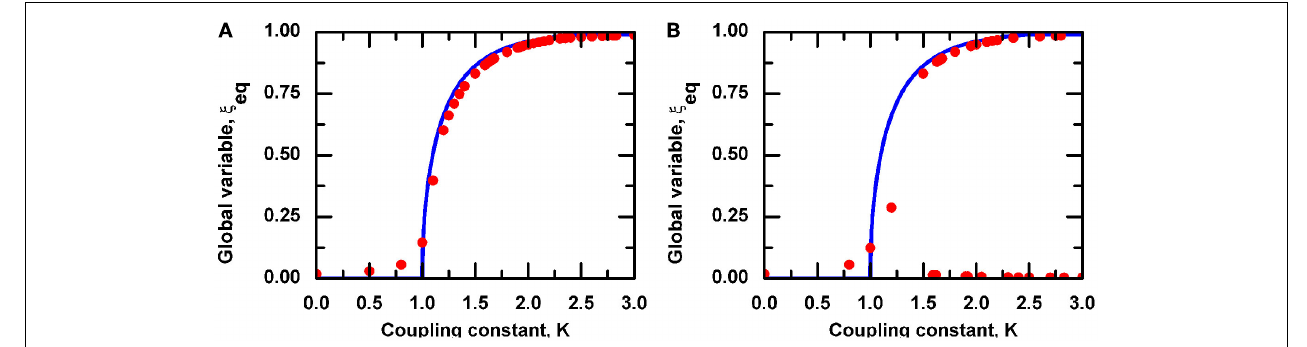
evaluating the dynamics of the decision making model on a system of two scale-free ad hoc networks, each having N = 1000 nodes and scaling exponent ν = 1.Those networks are coupled with only one randomly created link. In both cases scale-free ad hoc networks were generated according to the probabilistic algorithm of Kalisky et al.,